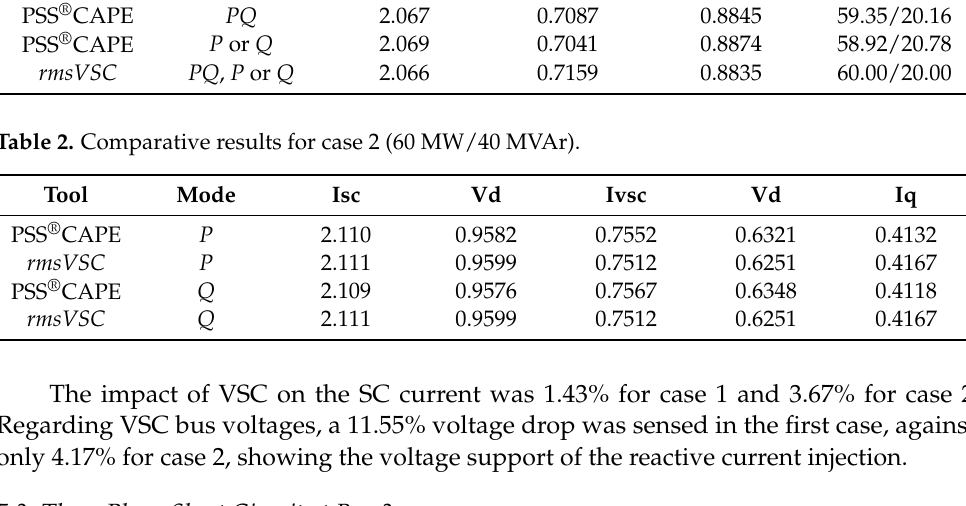
Figure 3. Short-circuit current (relative to the non-VSC value) considering a VSC connected at the faulted bus, for different SCR values and for two different operating modes.